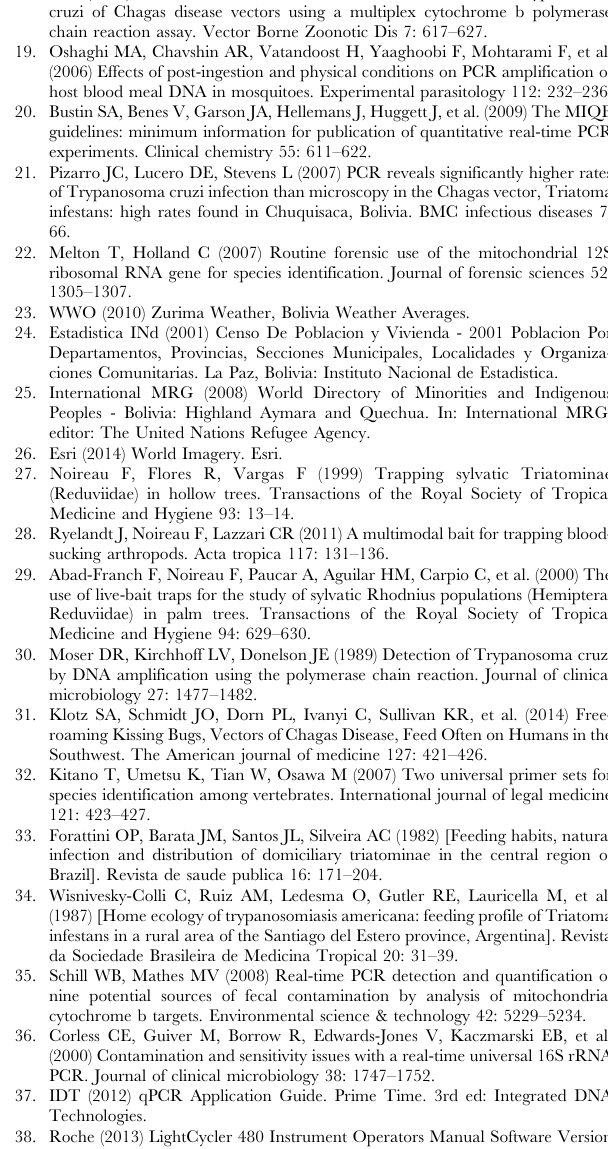
Table S1 Summary of trap sites and isolated houses.